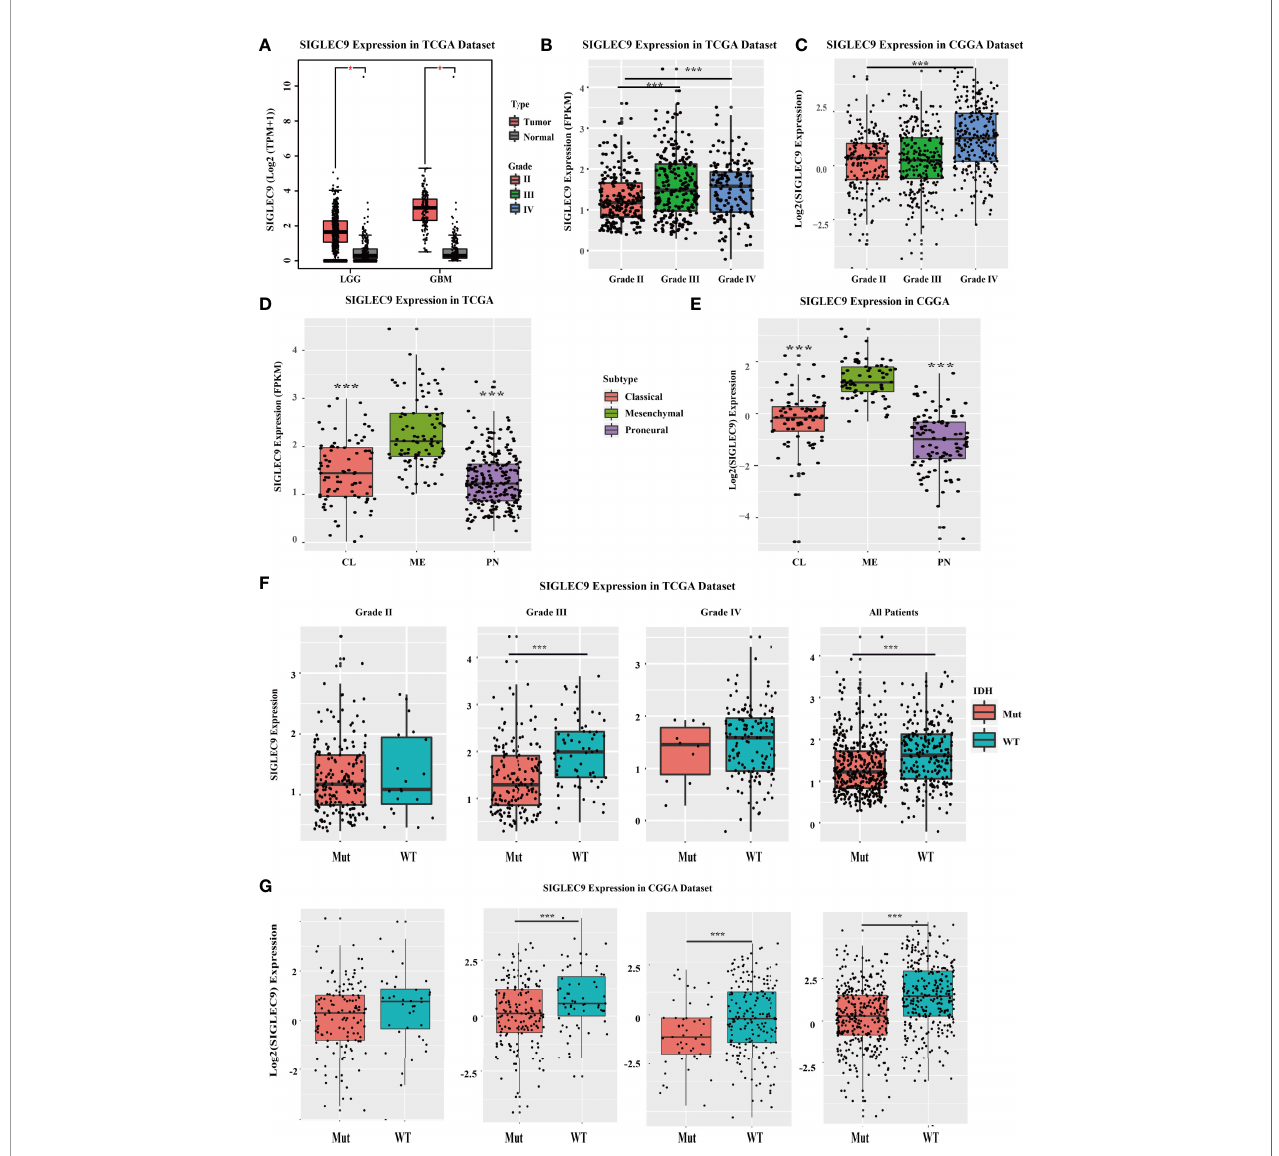
FIGURE 1 | The SIGLEC9 expression in different grades and subtypes with The Cancer Genome Atlas (TCGA) and the Chinese Glioma Genome Atlas (CGGA) databases. (A) The expression of SIGLEC9 in low-grade glioma (LGG) and glioblastoma multiforme (GBM) with TCGA database. In LGG patients, SIGLEC9 expression was higher in tumor tissue than in adjacent normal tissue (*<0.05). In GBM patients, SIGLEC9 expression was higher in tumor tissue than in adjacent normal tissue (*<0.05). (B) The SIGLEC9 expression in grade III patients was higher than in grade II patients with TCGA database (***<0.001). The SIGLEC9 expression in grade IV patients was higher than in grade II patients with TCGA database (***<0.001). (C) The SIGLEC9 expression in grade IV patients was higher than in grade II patients with CGGA database (***<0.001). (D) The SIGLEC9 expression in the mesenchymal subtype was higher than in the classic and proneural subtypes with TCGA database (***<0.001). (E) The SIGLEC9 expression in the mesenchymal subtype was higher than in the classic and proneural subtypes with CGGA database (***<0.001). (F) In grade II glioma patients with TCGA database, SIGLEC9 expression was higher in isocitrate dehydrogenase (IDH) wild-type patients than in IDH mutated patients (***<0.001). In all glioma patients with TCGA database, SIGLEC9 expression was higher in IDH wild-type patients than in IDH mutated patients (***<0.001). (G) In grade II and III glioma patients with CGGA database, SIGLEC9 expression was higher in IDH wild-type patients than in IDH mutated patients (***<0.001). In all glioma patients with CGGA database, SIGLEC9 expression was higher in IDH wild-type patients than in IDH mutated patients